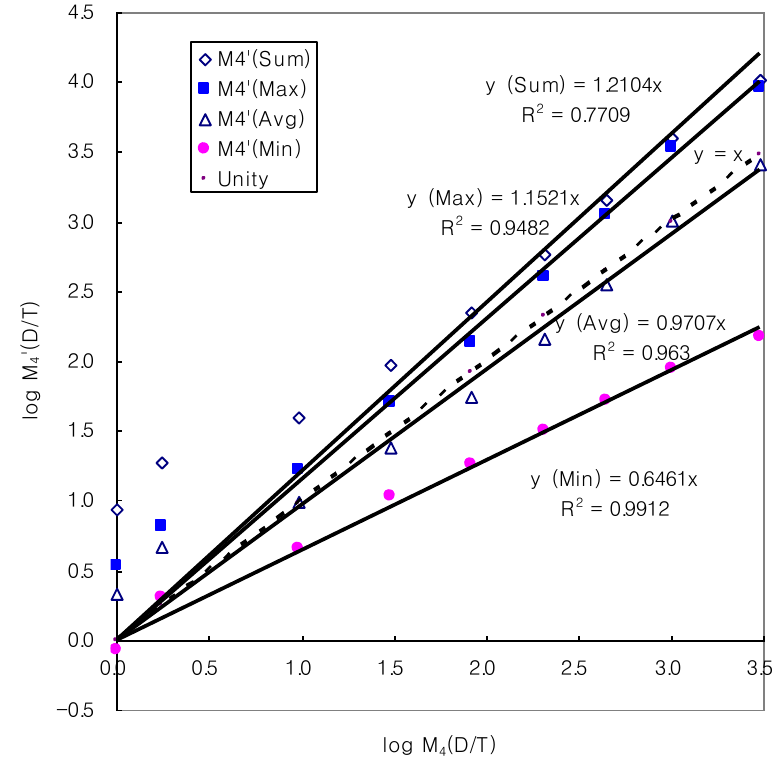
Figure 3. Correlation analysis of log (D/T) values between measured values of log (M and 4 types of statistical derivatives with prime symbol (M